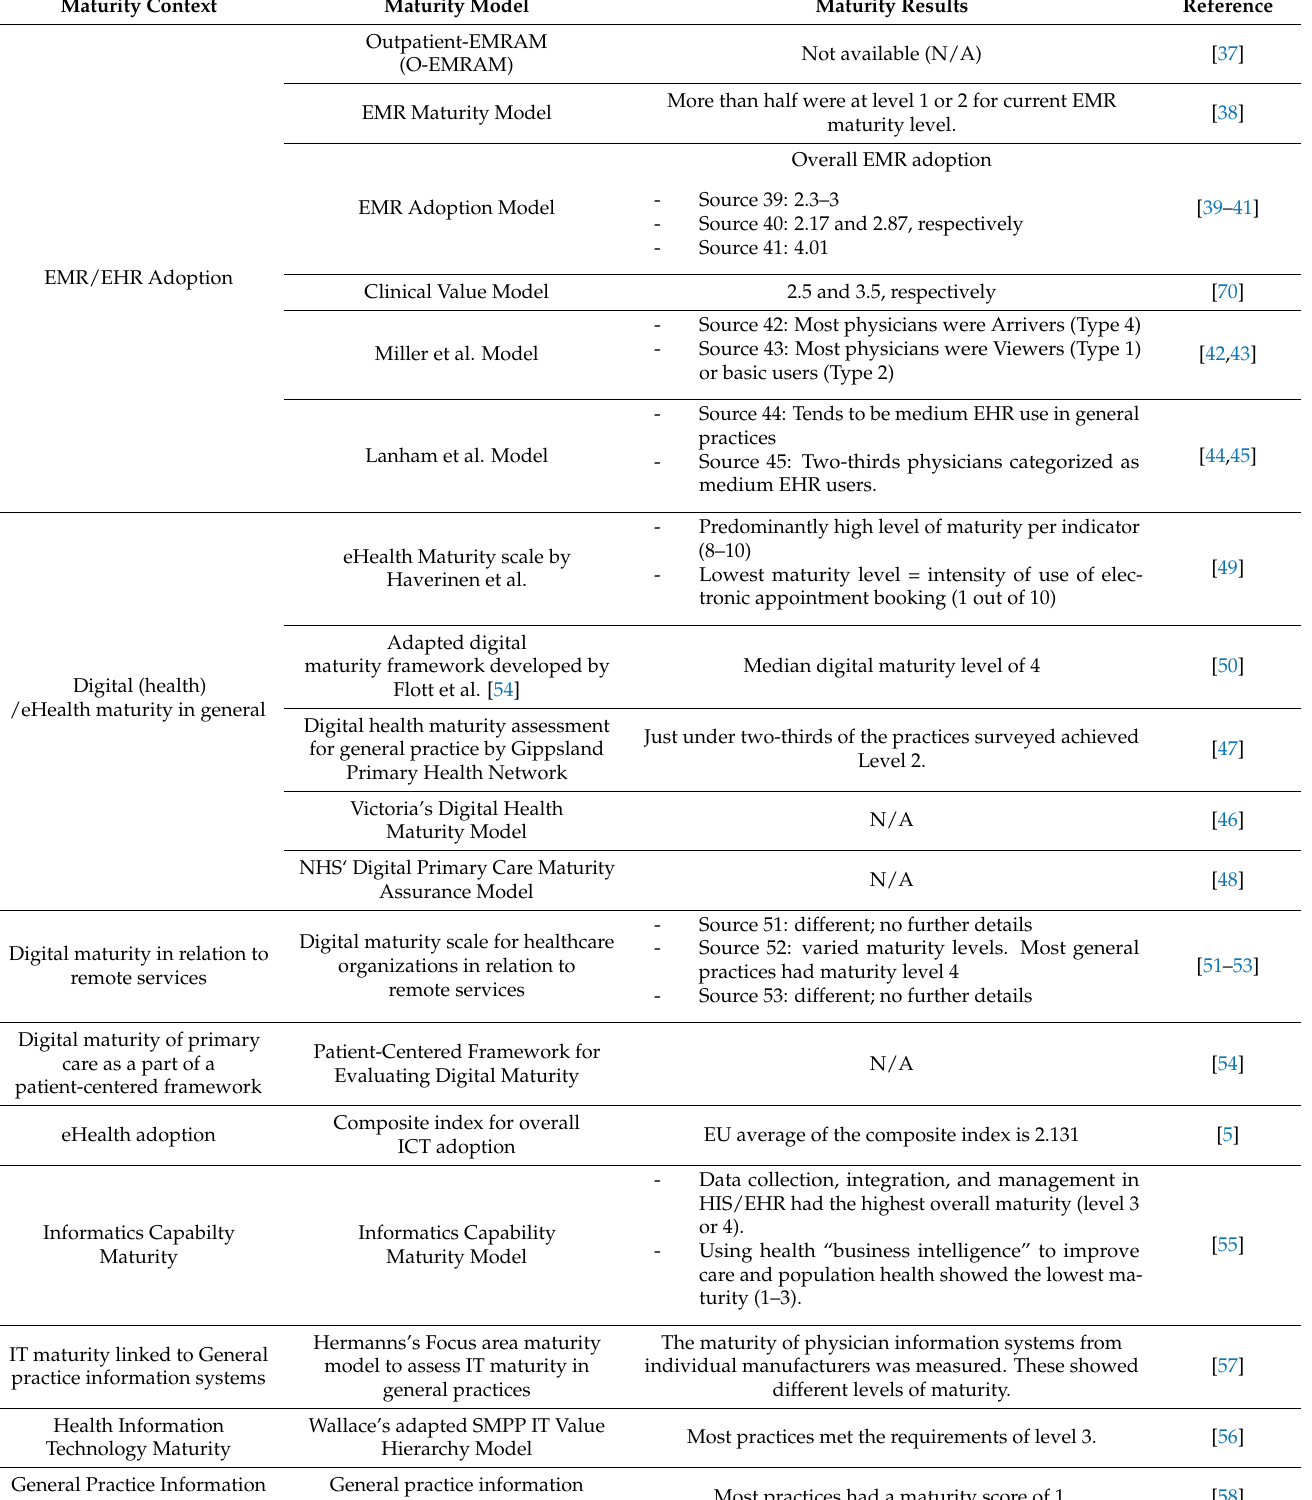
Table A2. Results of maturity